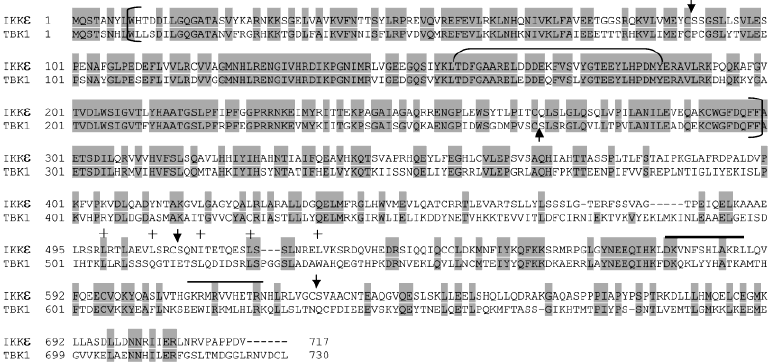
Figure 10. Alignment of protein sequences of human IKK ε and TBK1. The solid backgrounds indicate identical amino acid residues. Vertical brackets define the KD, while the horizontal bracket denotes the kinase activation loop. The heptad repeats of hydrophobic residues within the putative leucine zipper domain are indicated with “+” symbols. Two helices of the potential helix -loop-helix domain are overlined. These domains were predicted previously by Shimada et al. [65] and Peters et al. [45] and mostly validated by the crystal structures of human TBK1 [37,38]. The predicated NS3/NS4A cleavage sites on IKK ε and TBK1 (Table 1) are represented by arrowheads on top (IKK ε ) or bottom (TBK1) of their protein sequences. Human IKK α and IKK β are highly homologous canonical IKK kinases [35]. Notably, HCV NS3/NS4A cleaved both IKK α and IKK β into several fragments (Figure 2). One of the predicted cleavage sites in both IKK α and IKK β is in their respective kinase activation loops containing the mitogen-activated protein (MAP)-kinase kinase consensus motif SXXXS, where X is any amino acid residue [70 – 73] (S176 and S180 in IKK α , S177 and S181 in IKK β , Table 1). The X-ray crystal and cryo-EM structures of human IKK α [35], and the X-ray crystal structures of human IKK β [69,74] show that their classical kinase activation loops protrude outside of their KDs before the phosphorylation of two serine residues and subsequent kinase activation (data not shown), and are well exposed to solvent even after serine phosphorylation (Figure 9A,B). In other words, the kinase activation loops in IKK α and IKK β , regardless of their serine phosphorylation status, will be accessible by HCV NS3/NS4A for cleavage. Consistently, the kinase activation loops are predicted to be cleaved by NS3/NS4A right after C178 in IKK α and C179 in IKK β (Table 1) and these cysteine residues are on the surface of activated IKK α and IKK β (Figure 9A,B). Thus, we hypothesize that the observed time-dependent decreases in the kinase activities of IKK α and IKK β (Figures 4 and 5) were mainly due to the gradual cleavage of the kinase activa- tion loops in these kinases by HCV NS3/NS4A. It is possible that the kinase activity de- creases also contributed through the NS3/NS4A cleavage at other predicated sites of the KDs of IKK α and IKK β (Table 1), e.g., the cleavage of the ULD of IKK α (Figure 9A). The exact NS3/NS4A cleavage sites in IKK α and IKK β will be unambiguously identified through future sequencing of the isolated peptide fragments by mass spectrometry anal- ysis.